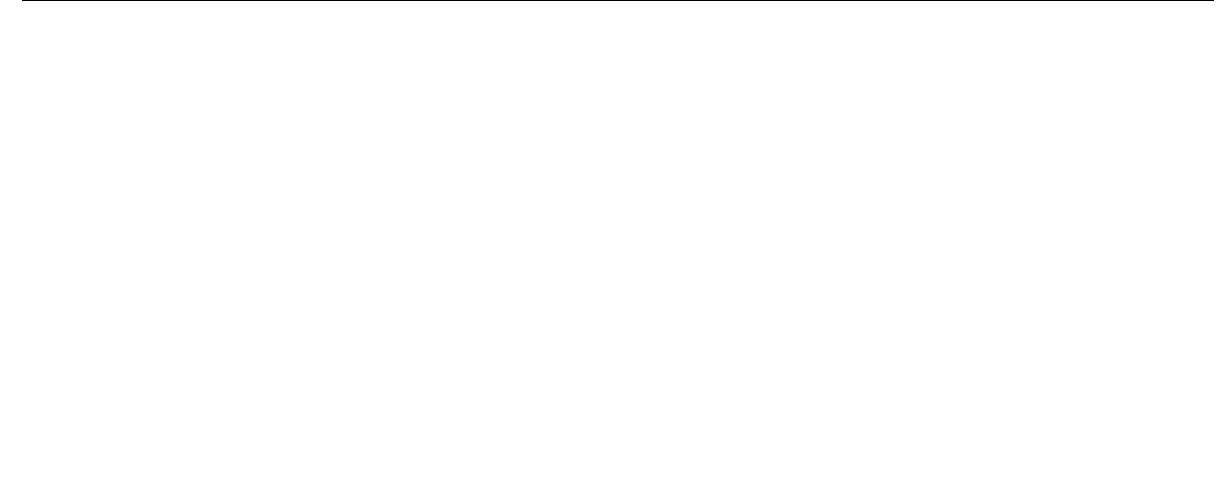
Fig. 13 Experiment results of experiment No. EXP 3F of GIII sample. a Pore water pressure and vertical displacement curves b Hydraulic gradient and TSS